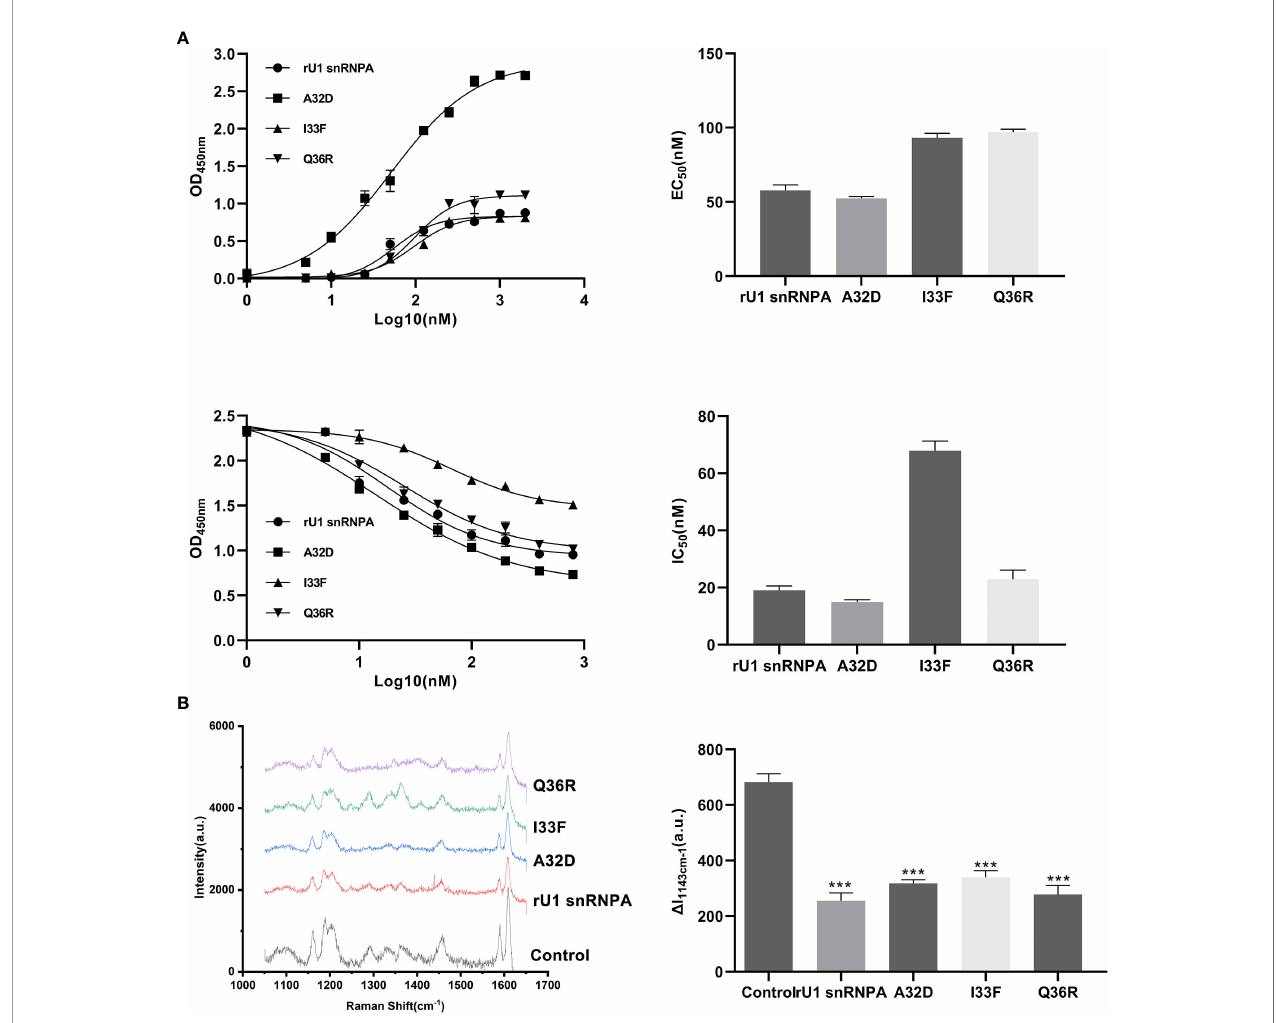
FIGURE 7 | Results of binding ability changes of variants. (A) Binding curves and inhibition curves of the variants. Charts of EC50 and IC50. Curve fi tting was performed by using GraphPad Prism 8.0. The experiment was performed in double for each sample group. Data are shown as mean ± SD. (B) Comparison of the SERS spectra of the variants (both 1.5 m M). The characteristic peaks of 4-ABP are marked in gray. l ex = 632.8 nm, t = 5 s, and accumulation times = 1. Data are shown as mean ± SD. ***P <